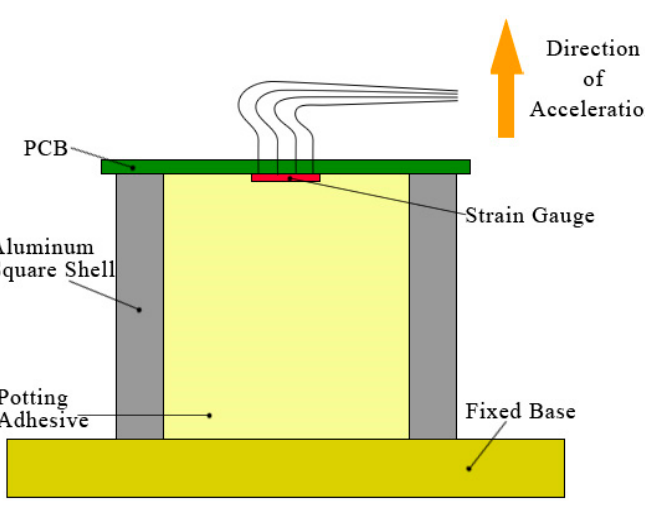
Figure 1. Schematic diagram of the testing device.